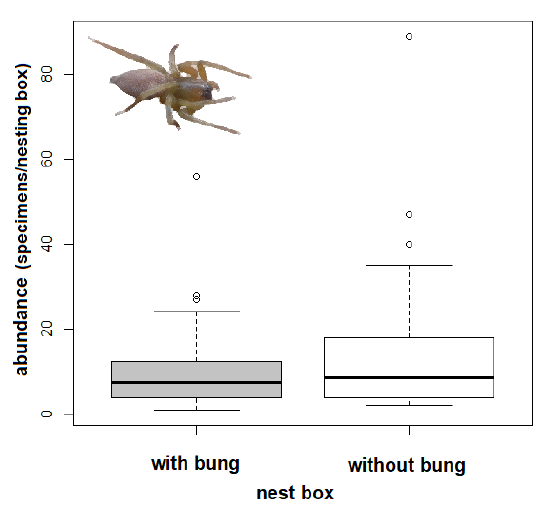
Figure 2. Comparison of the number of spider specimens per box and inspection (abundance = individuals) in bunged nesting boxes and boxes without a bung (sampled once in winter of 2015, 2016, and 2017), bold lines in the box plot are the median and the lines are 95% CI, the dots are outliers.